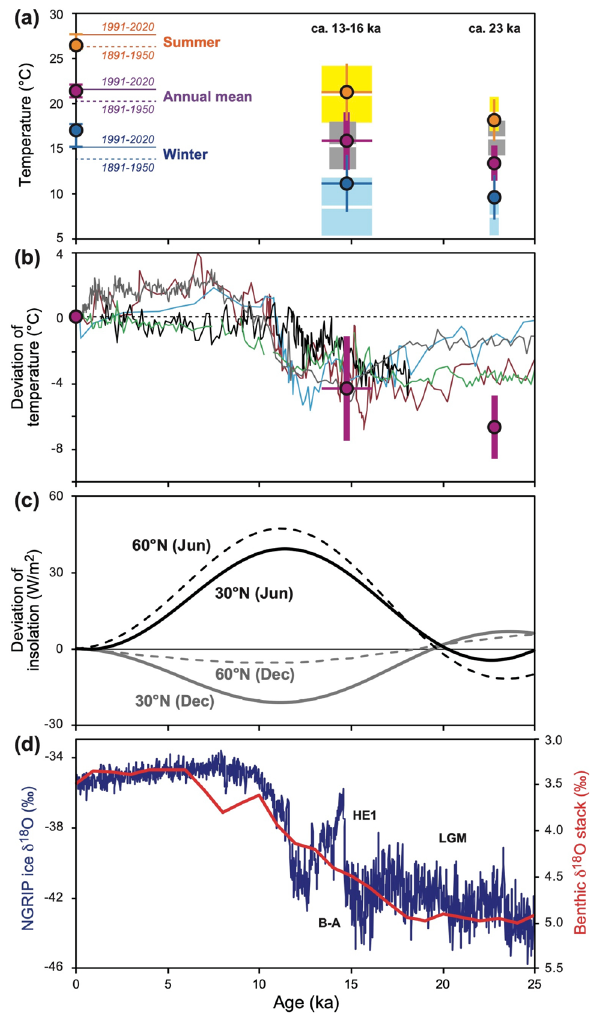
Figure 3. ( a ) Reconstructed annual mean (purple), summer (orange), and winter (blue) air temperatures (± 1σ) on Okinawa Island at 23.1–22.5 ka and 16.1–13.4 ka. Present-day average air temperatures around the study site were estimated from data from the Itokazu meteorological station, and are shown for 1891–1950 (dotted line) and 1991–2020 (solid line). Air temperatures reconstructed from a combination of coeval stalagmite calcite and fluid inclusion water δ 18 O data at 23.4–22.4 ka and 15.2–13.8 ka are shown in white (average) and gray (± 1σ). Reconstructed air temperatures from previously reported fossil snail δ 18 O data 24 using our method are also shown (summer = white and yellow; winter = white and light blue). ( b ) A comparison of relative annual mean temperatures (purple; this study) with relative seawater temperature variations obtained from planktonic foraminifers and alkenones in deep-sea sediments in Okinawa Trough: black 7 and green 43 and off the eastern coast of Japan: light blue 41 , gray 42 , and brown 44 . The present-day value of zero is based on 1891–1950 for this study and the late Holocene for the others. ( c ) Deviations of June and December insolation at 30° N and 60° N relative to today 39 . ( d ) Greenland ice core δ 18 O record from the North Greenland Ice Core Project (NGRIP) (blue 37 ) and benthic foraminifer δ 18 O stack record for the Pacific Ocean (red 38 ). Probable timings of the late LGM, the Heinrich Event 1 (HE1), and Bølling–Allerød (B–A) are indicated. Paleoclimate data are available at the NOAA NCDC data archive (https:// www. ncdc. noaa. gov/ data- access/ paleo clima tology-